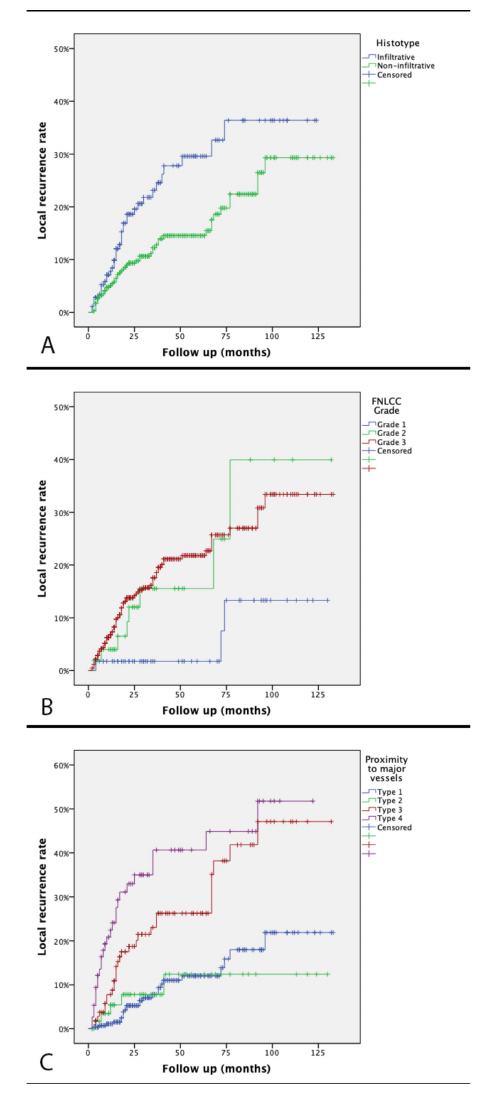
Figure 2. Kaplan–Meier local recurrence curve according to histotype ( A ), FNLCC grade ( B ), and proximity to major vessels ( C